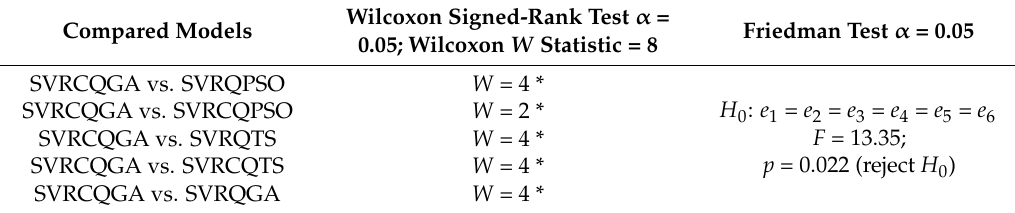
Table 7. Wilcoxon signed-rank test and Friedman test (Example 2).